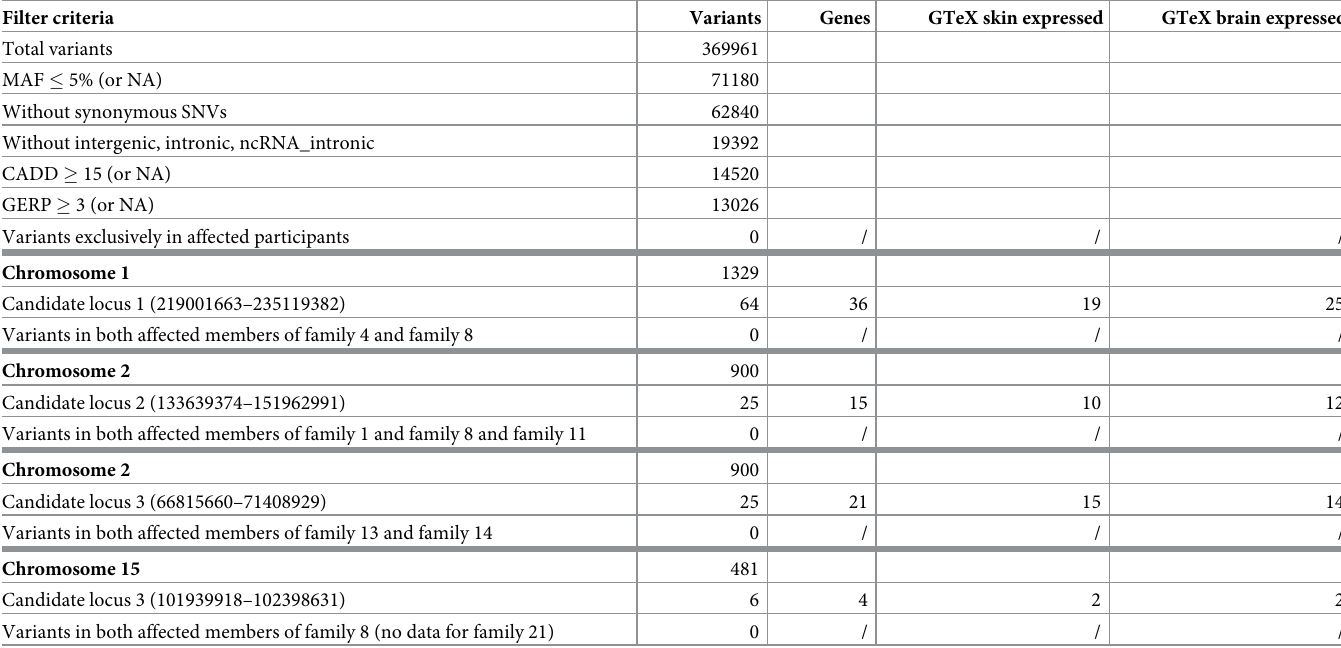
Table 2. Overview about the filtering process of whole exome sequencing data in the regions identified via linkage analysis. Filter